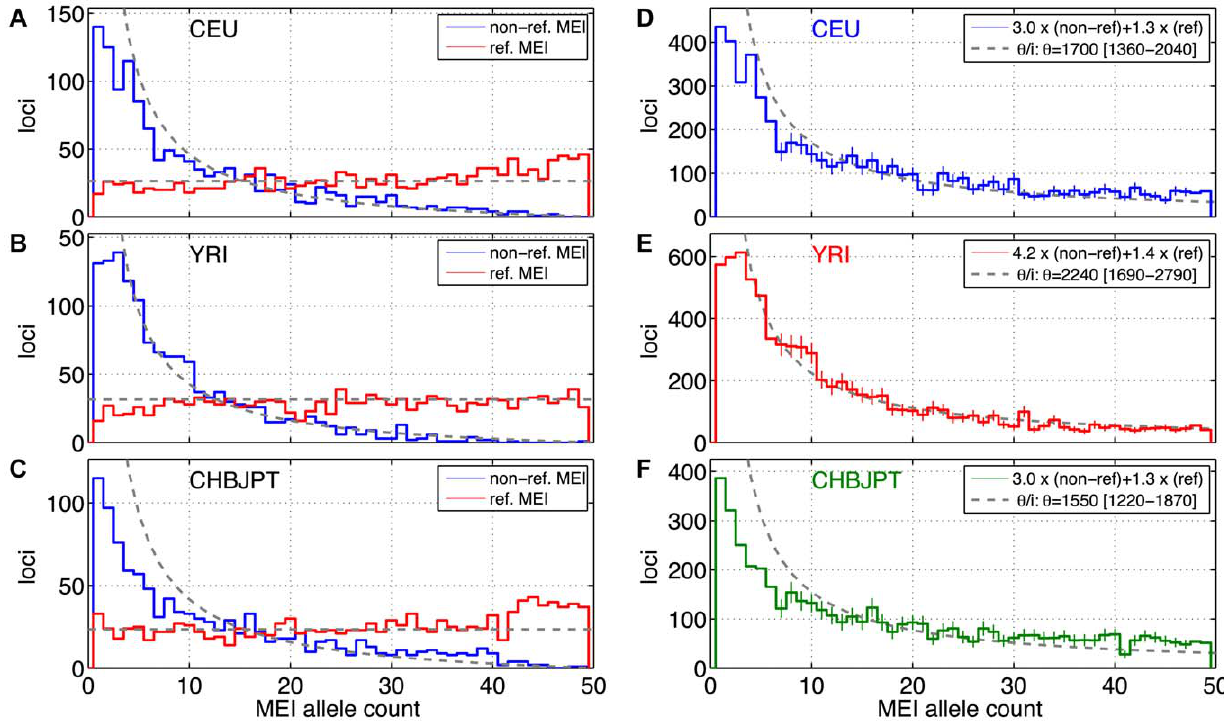
Figure 5. MEI allele count spectrum. a–c) Uncorrected allele count spectra. Non-reference MEI (blue) and reference MEI (red): a) CEU, b) YRI, c) CHBJPT. Loci with 25 or more genotyped samples were included. A random subset of 25 samples was selected for any locus with more than 25 genotyped samples. Gray dashed lines are based on neutral model fits from the full MEI spectra, modified to account for the respective ascertainment conditions, ( h /2N) for reference MEI, ( h /i)(2N 2 i)/(2N) for non-reference MEI, where N =25 is the number of samples in the spectrum. d–f) MEI allele count spectra. d) CEU, e) YRI, f) CHBJPT. The spectra are corrected for each detection mode sensitivity and genotyping efficiency according to the expression in the legend. Gray dashed line is a fit to h /i, where i is the allele count and h is the diversity parameter. Only counts in the range